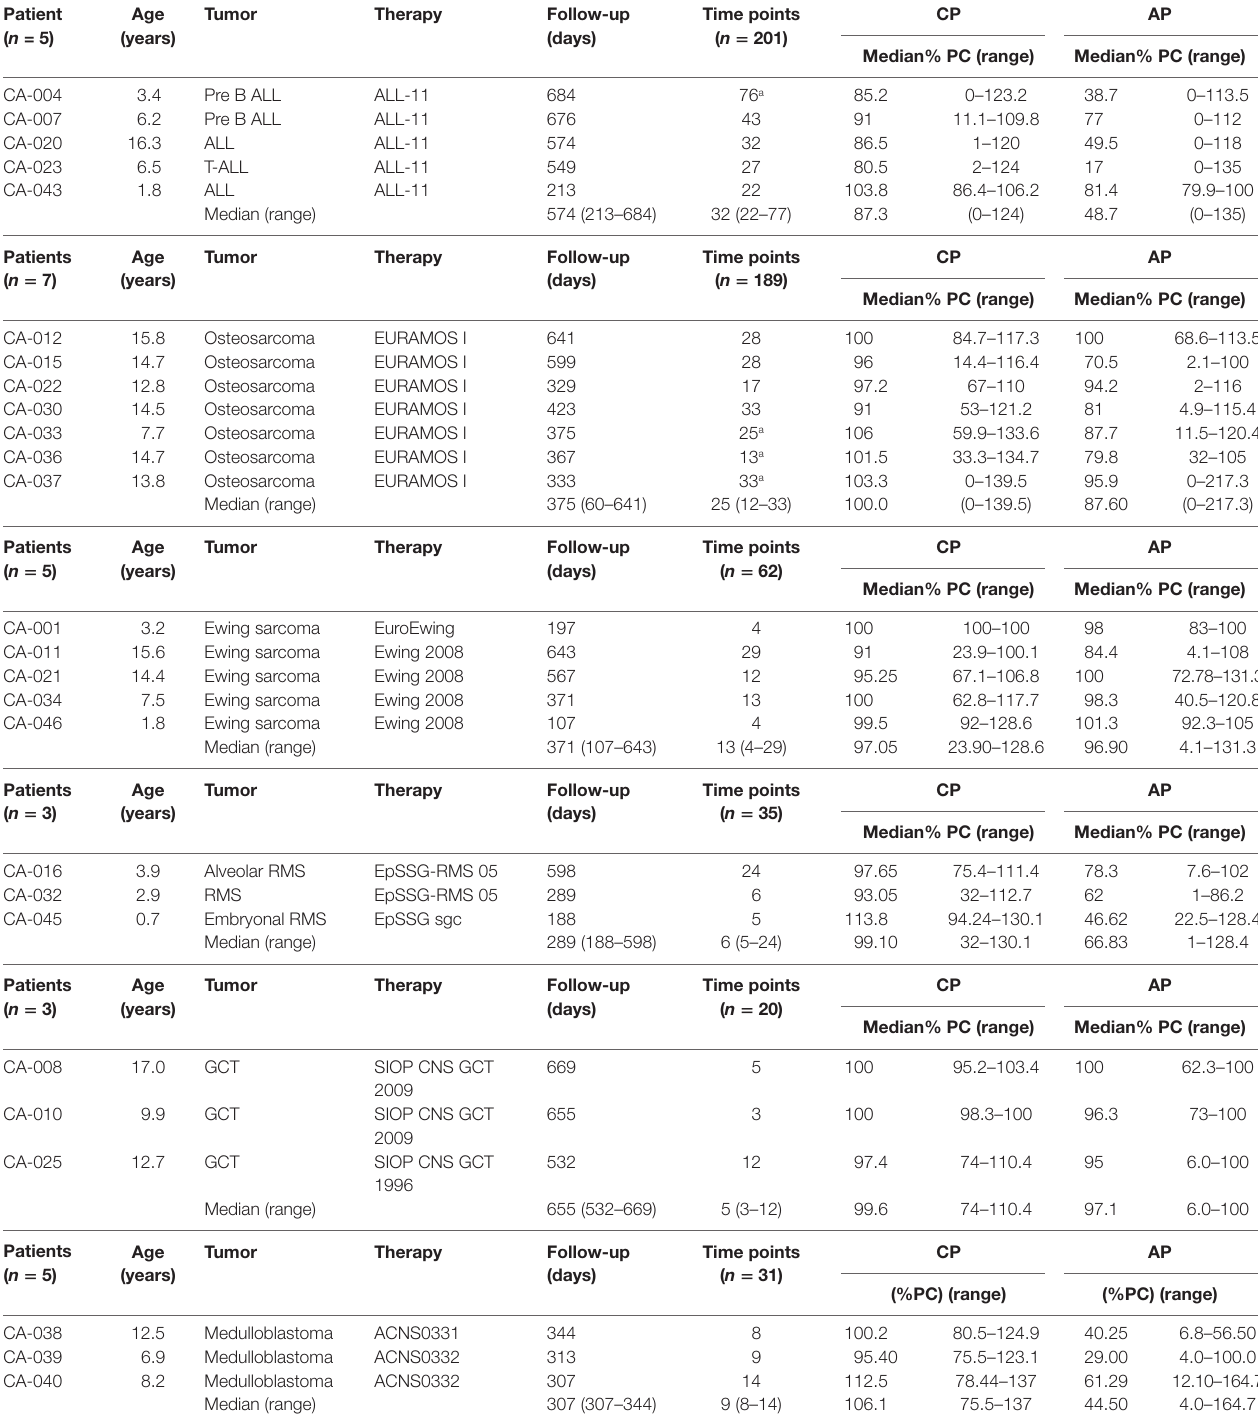
TaBle 2 | complement activation functionality of patients within six different therapy